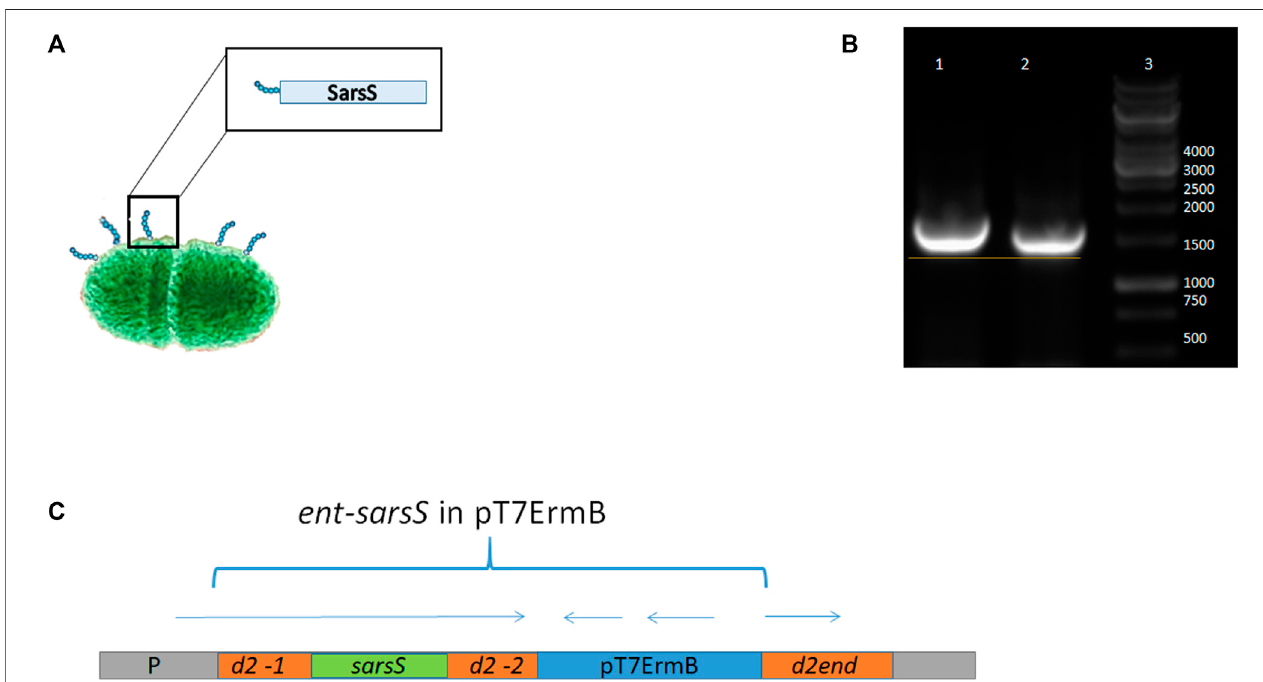
FIGURE4| Schematic representation ofSARS-Cov-2DNAfragment integration in enterococcal piligene. (A) Putativeenterococcal cellwithpiliprotein containing S1proteinfragment. (B) PCRwithDNAprimers fl ankingtheinsertinthestrainL3-SARSrelatively totheappropriateregionofthestrain-recipient E.faecium L3.Itcanbe seen that in the recombinant strain the DNA insert is slightly larger due to the insertion of SARS-Cov-2 DNA. (C) Scheme of the genomic region of enterococci after the integration of the plasmid pentF-sarsS into E. faecium L3 genome.